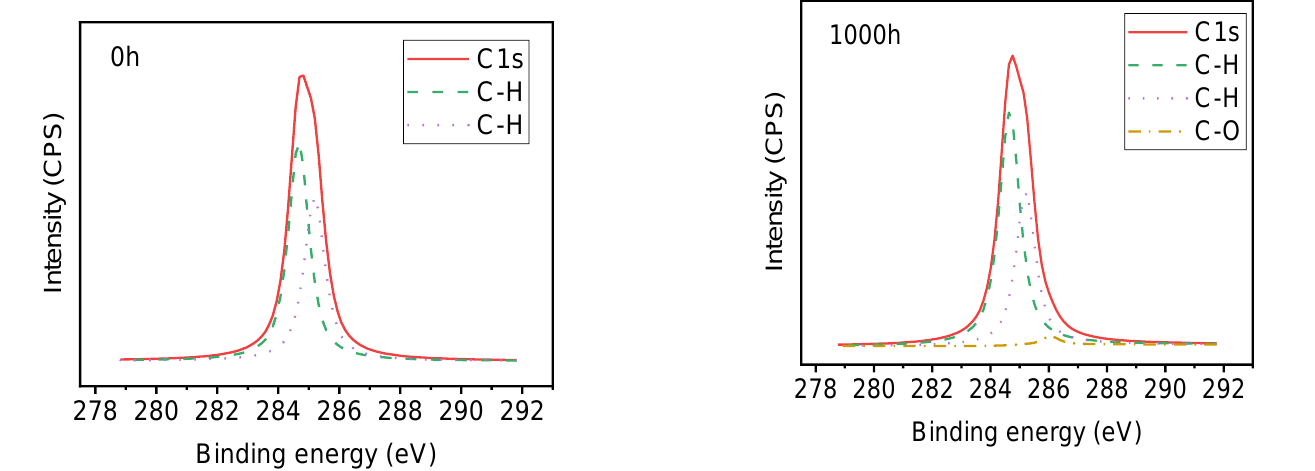
Figure 15. Peak fitting of C in HTV silicone rubber samples. Table 3. Comparison of the position of peak binding energy and contents of three elements of both samples after 1000 h UV-A aging time.